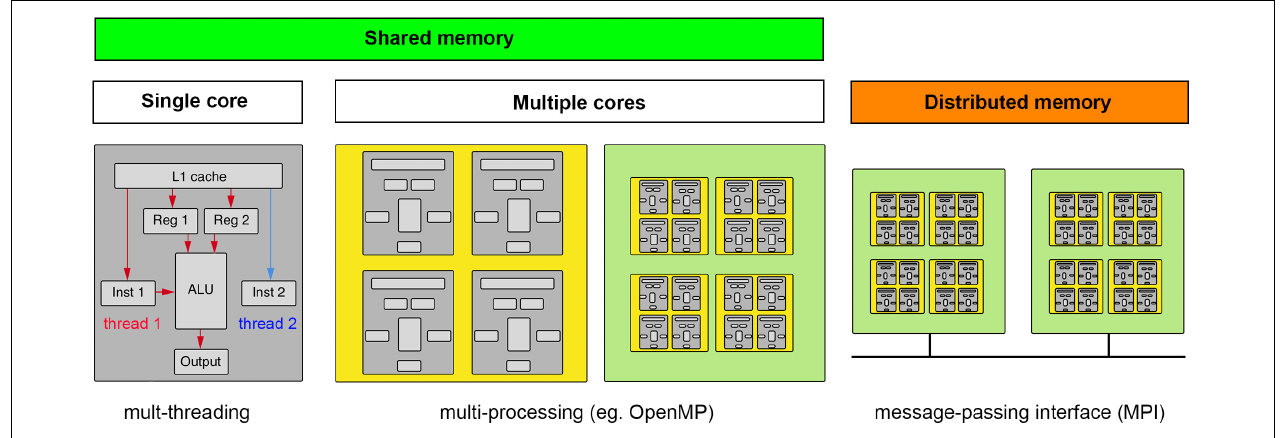
FIGURE 5 | Computing concepts for scaling up and scaling out. Computation requires data and instructions to be loaded into registers directly accessible by an arithmetic logic unit (ALU). Multi-threading makes computations parallel by taking advantage of dead time when data are being fetched. Multi-processing is when the computation can be spread to multiple cores (ALUs), whether on a CPU or GPU, that have access to the same memory (GPU’s typically having their own smaller on-board memory). If the data and/or computations do not fit in shared memory, a message-passing interface must help coordinate the broadcasting of data and computations across a distributed memory system. (gray, core; yellow, CPU; green,